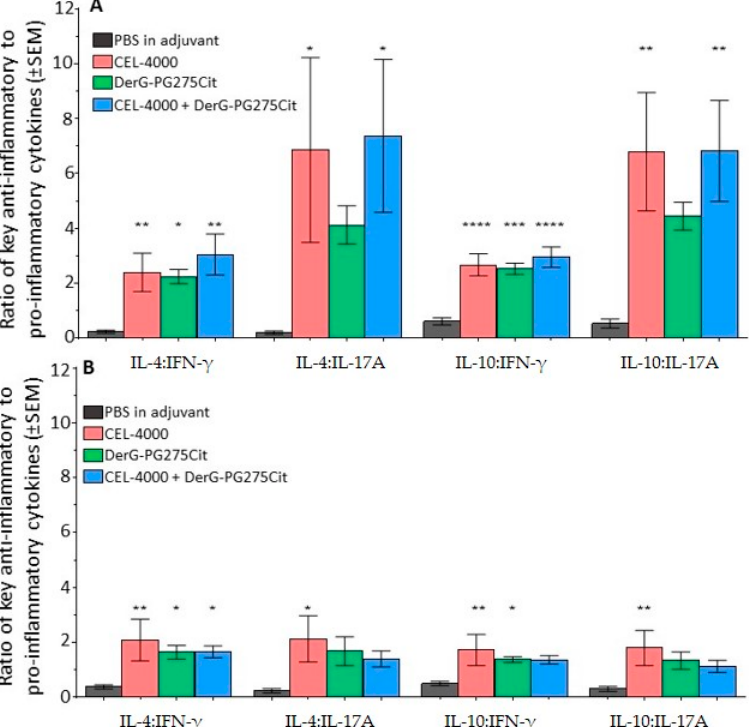
Figure 8. Cytokine production by spleen cells from control and LEAPS vaccine treated GIA mice. Spleen cells obtained from control or vaccinated GIA mice ( n = 8 per group) from study 2 were either non-restimulated or restimulated with rhG1 antigen in culture for 4 days and then media samples were assayed for released cytokines. Cytokine results were obtained using Millipore’s Luminex MagPix instrument and R&D Systems’ Mouse Magnetic Luminex Assay kits (Biotechne brand). Results are presented as ratios of key anti-inflammatory to pro-inflammatory cytokines (to be comparable with the intracellular cytokine ratios shown in Figure 7) secreted by ( A ) Non-restimulated cell cultures and ( B ) Antigen-restimulated cell cultures (* p ≤ 0.05, ** p ≤ 0.01, *** p ≤ 0.001, **** p ≤ 0.0001). Statistical analysis was performed using one-way ANOVA and Fischer’s LSD multiple comparison tests. The concentrations of these four and a few additional cytokines are shown in Supplemental Figure S2.